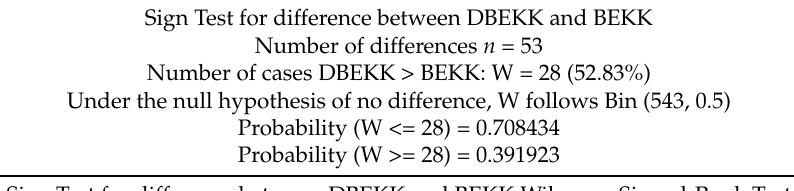
Table 6. Sign Tests of the differences in estimates produced by DBEKK and FULL BEKK: all coefficients. Sign Test for difference between DBEKK and BEKK Number of differences n = 53 Number of cases DBEKK > BEKK: W = 28 (52.83%) Under the null hypothesis of no difference, W follows Bin (543, 0.5)